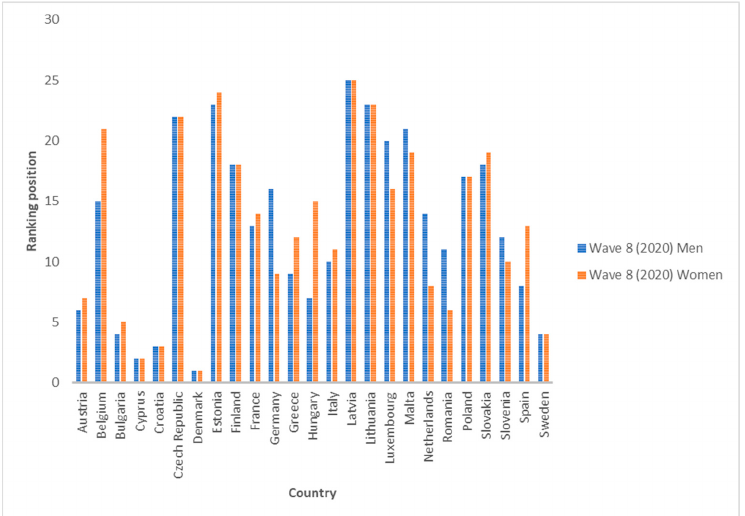
Figure 5. Position in the ranking of each country in Wave 8 (2020). Source: Authors’ elaboration based on SHARE (2021).